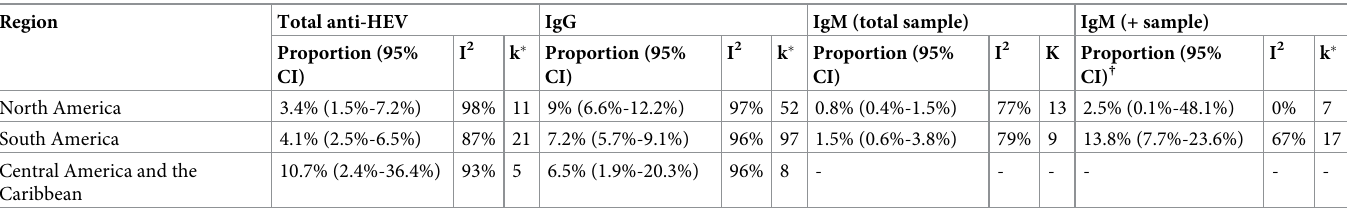
Table 2. Pooled analysis of HEV seroprevalence by region.